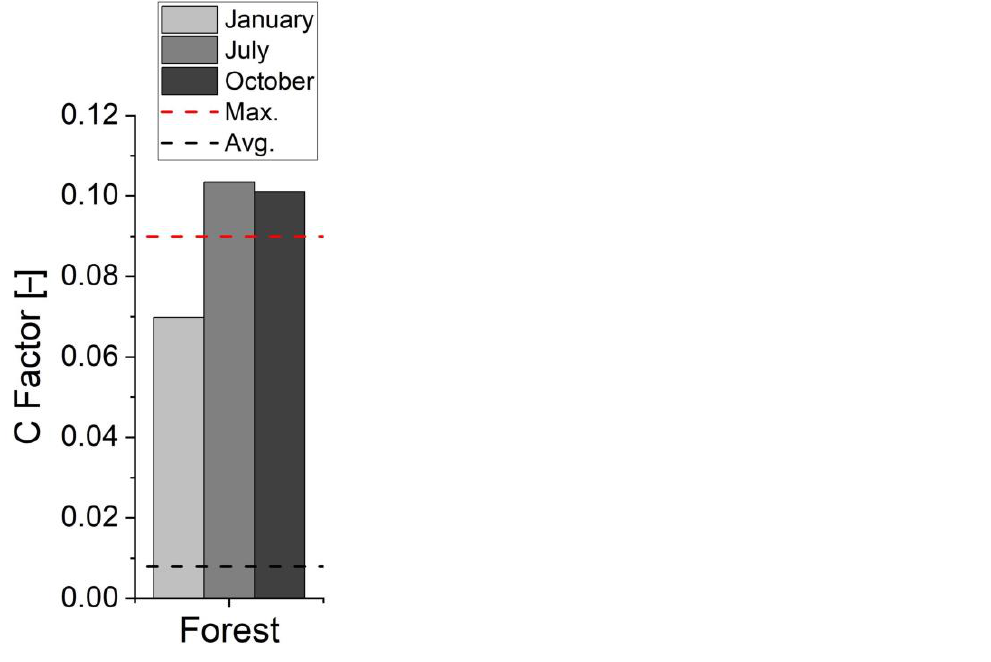
Figure 18. Comparison of the average C Factor to maximum and average values found in the literature.